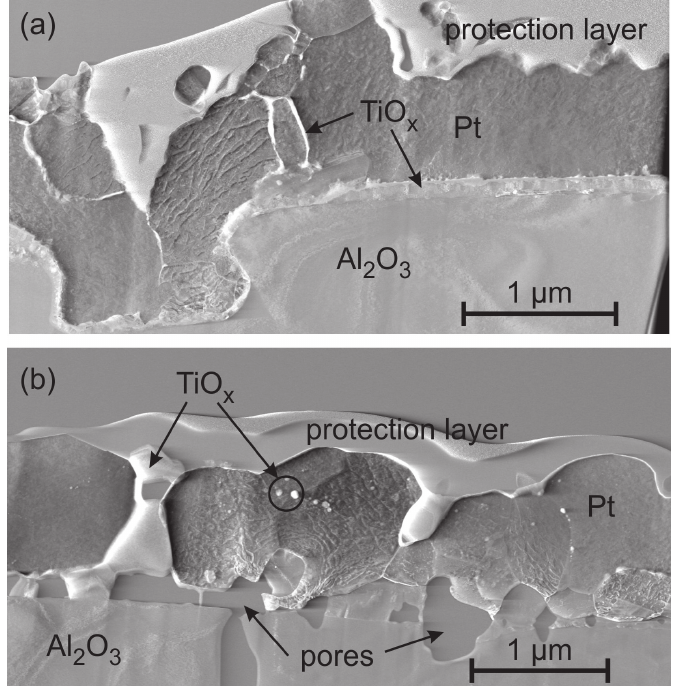
Figure 4. STEM image (grain orientation contrast) of the Pt ∗ film with Ti seed layer after annealing ( a ) at 600 ◦ C and ( b ) at 1000 ◦ C in